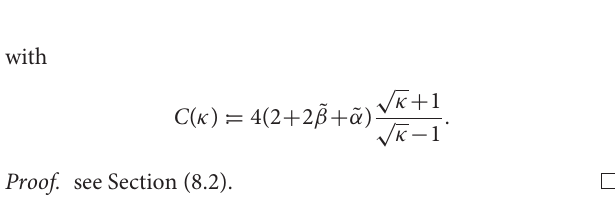
FIGURE 6 | Dependence on iteration number k of the upper bound (40) on error of HB (solid), upper bound (28) for error of GD (dashed) and lower bound (30) (dotted) for FOMs for the function class S L , U n with condition number U / L κ = =